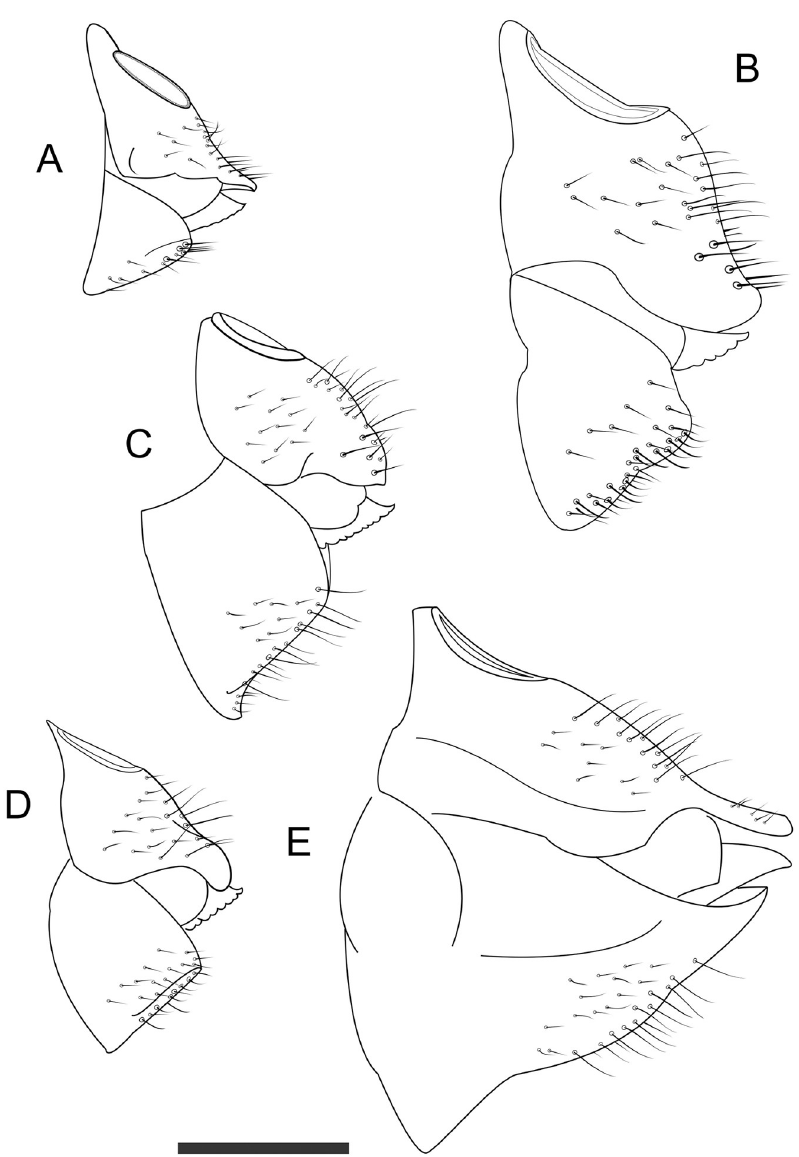
Fig 5. Lateral view of female terminalia of Trioza melaleucae ( A ), T . curta ( B ), T . adventicia ( C ), T . eugeniae ( D ) and T . erytreae ( E ). Scale bar is 0.2